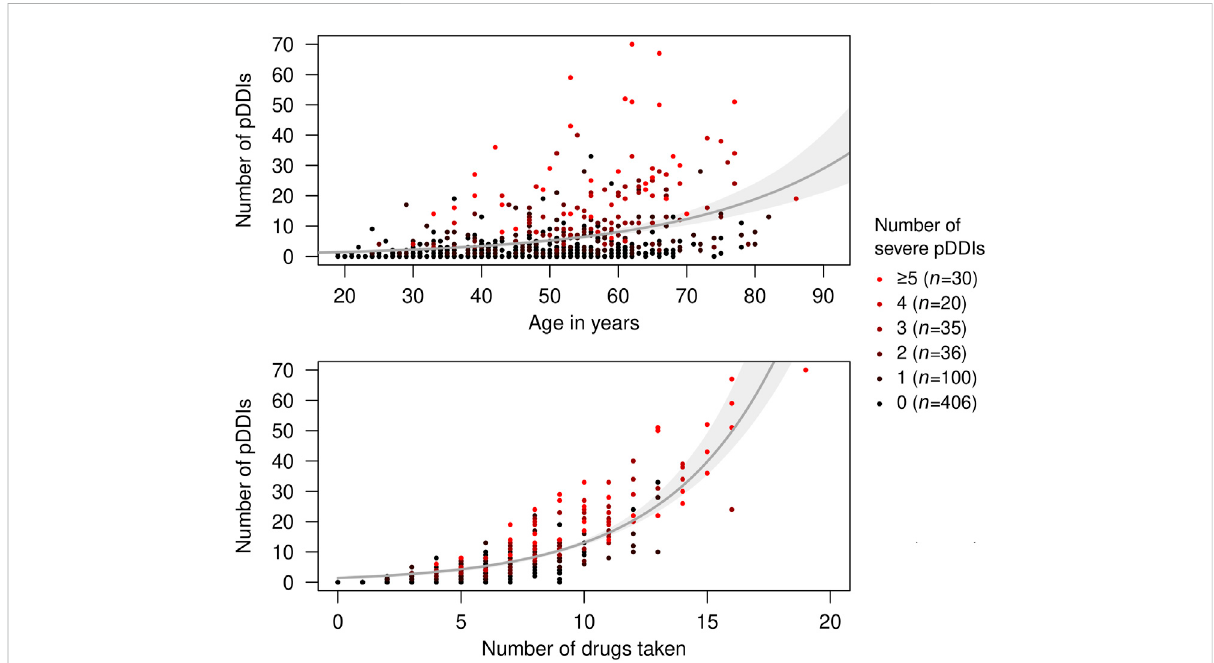
FIGURE 5 Frequency of potential drug-drug interactions in relation to age and number of drugs taken. The patients ( N = 627) took 5.3 medications on average. A subset of 441 patients had at least one pDDI according to at least one of the three databases used. Red dots in the scatterplot represent patients with multiple severe pDDIs. Fitted exponential curveswith 95% bootstrap con fi dence intervals are shown ingray.pDDI, potential drug-drug